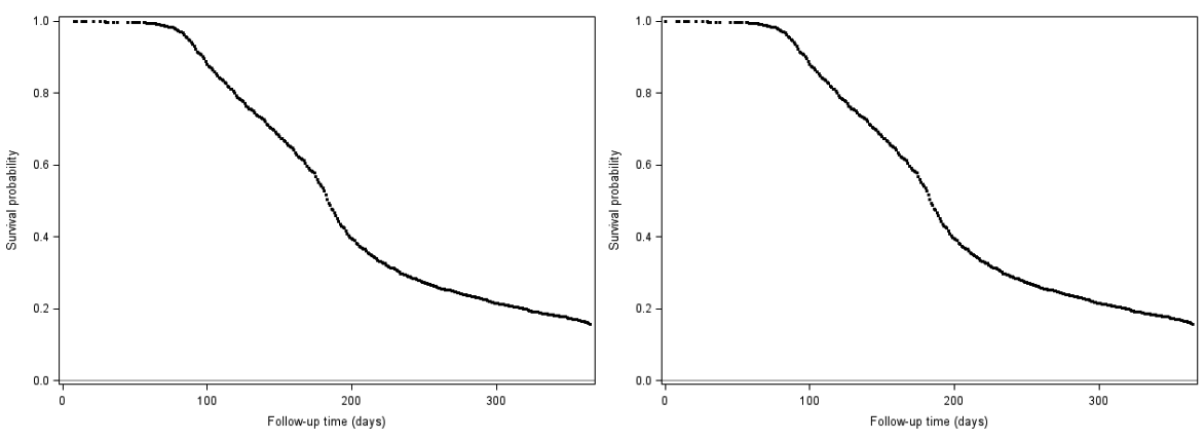
Figure 4. Comparison of survival functions between distributed cox proportional hazards regression (left) and pooled individual-level cox proportional hazards regression (right). The survival curves were evaluated at the mean value of covariates for patients with events.